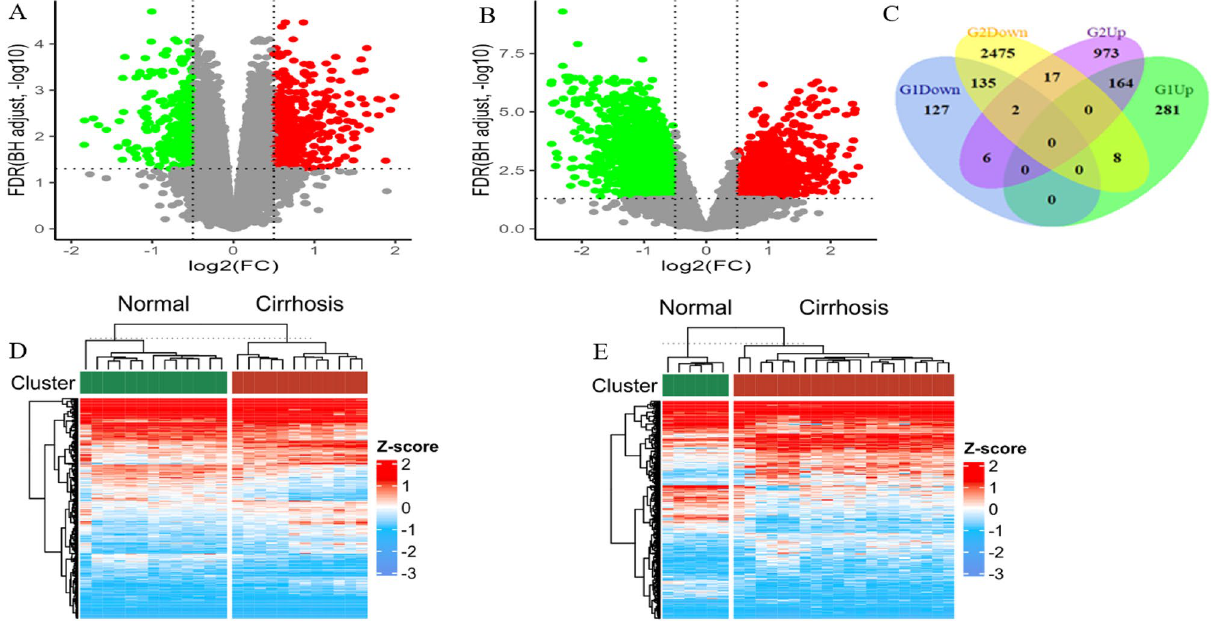
Figure 1. Volcano plots of all up- regulated genes ( A ) and down-regulated genes ( B ) show the DEGs between normal liver and cirrhosis samples from GSE89377 and GSE39602. Red indicates; greater expression and green indicates less expression. Venn Diagram ( C ) showing the upregulated and downregulated genes in the two datasets. The intersection of G1Down and G2Down represents downregulated genes in both datasets. The intersection of G1Up and G2Up represents upregulated genes in both datasets. An absolute log2 FC > 0.5 and an adjusted P value of < 0.05 cutoff was used to define differentially expressed mRNAs in cirrhosis. Heatmap ( D ) shows the genes expression changes between normal liver and cirrhosis samples from GSE89377. Heatmap ( E ) shows the genes expression change between normal liver and cirrhosis samples from GSE39602. DEGs: differentially expressed genes; G1Up: upregulated genes in GSE89377; G2Up: upregulated genes in GSE39602; G1Down: downregulated genes in GSE89377; G2Down: downregulated genes in